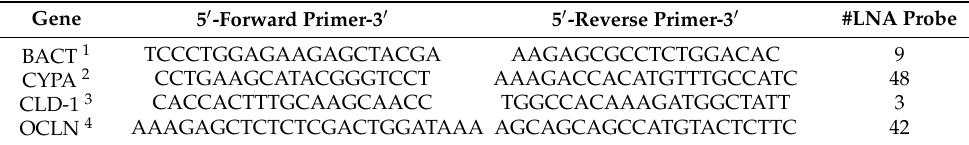
Table 1. Locked nucleic acid (LNA) probe-based real-time PCR systems. Gene 5 (cid:48) -Forward Primer-3